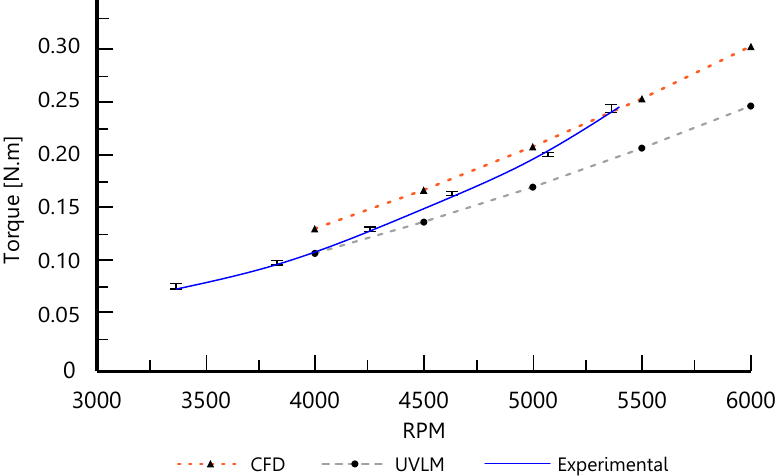
Figure 16. Experimental and computational